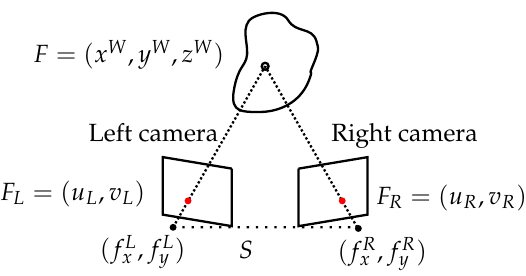
Figure 10. Triangulation geometry principle for a stereo system.